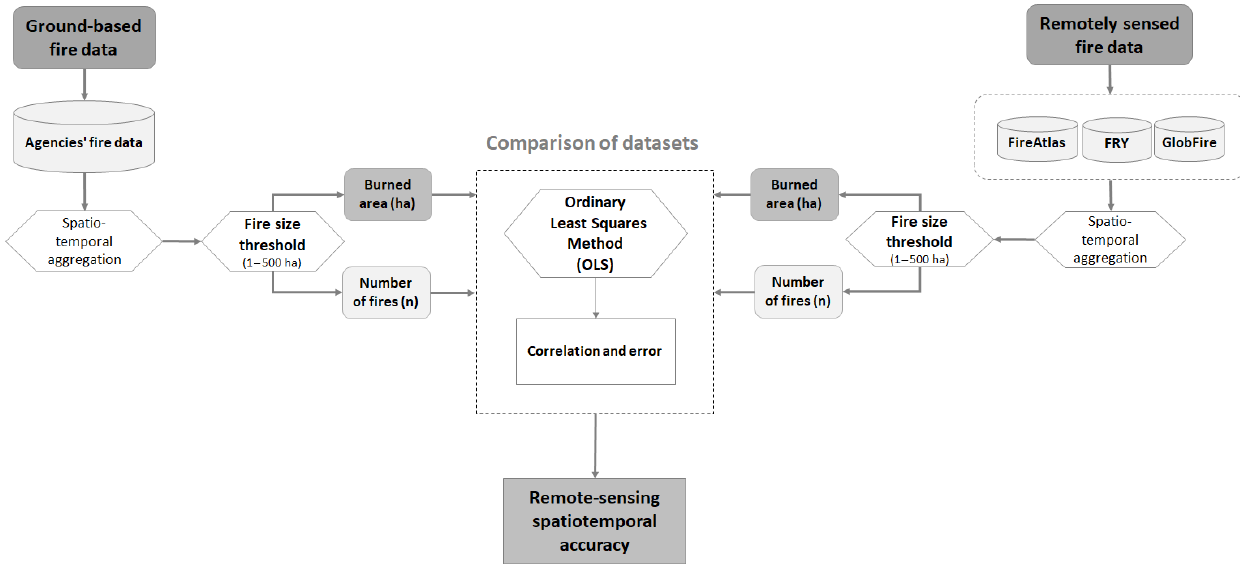
Figure 2. The general framework for comparison of RSDs with the GBD in terms of burned area (BA) and number of fires (NF) across a range of individual fire size thresholds (1 to